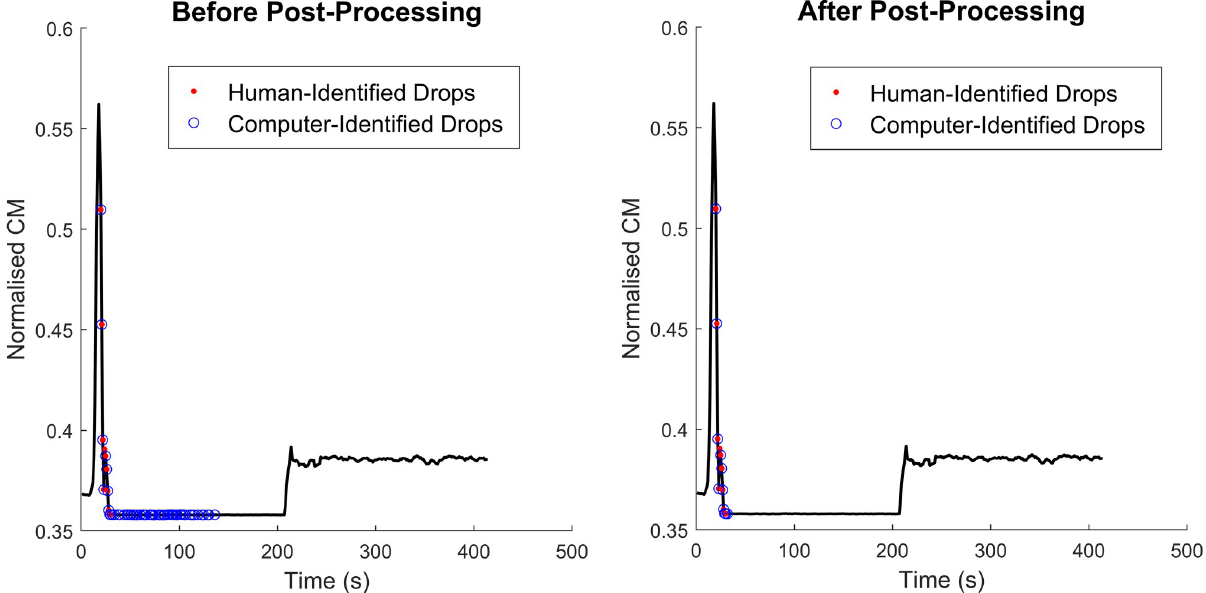
Fig 4. Results of the post-processing algorithm. The left panel shows the classification results prior to post-processing. The right panel shows how the post-processing algorithm has removed some of the misclassifications. Drop points detected by the human expert are given as red dots while those detected by the automated algorithm are given in blue